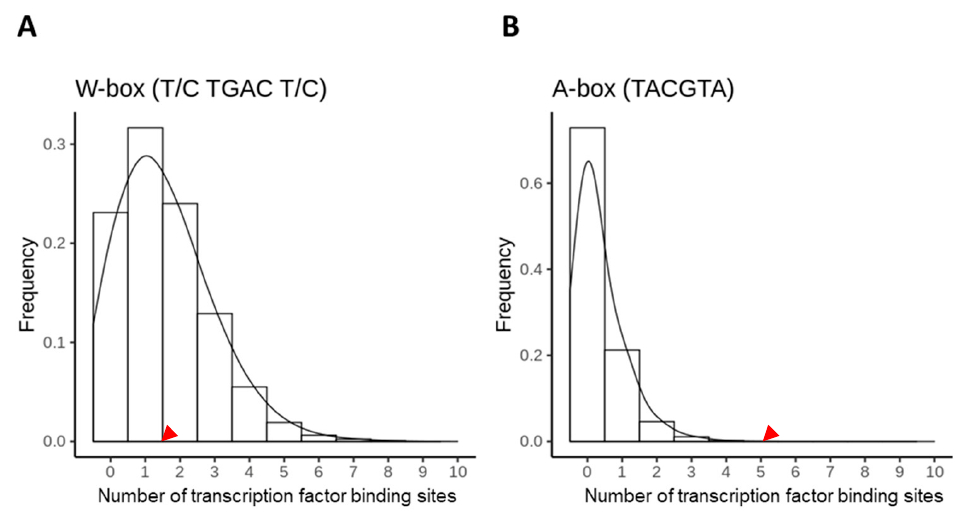
Figure 2. Distribution of ( A ) W-boxes and ( B ) A-boxes in all A. thaliana 2000 bp promoter regions. Red arrows indicate the number of corresponding elements observed in the AtSAG12 − 2000 bp promoter region.